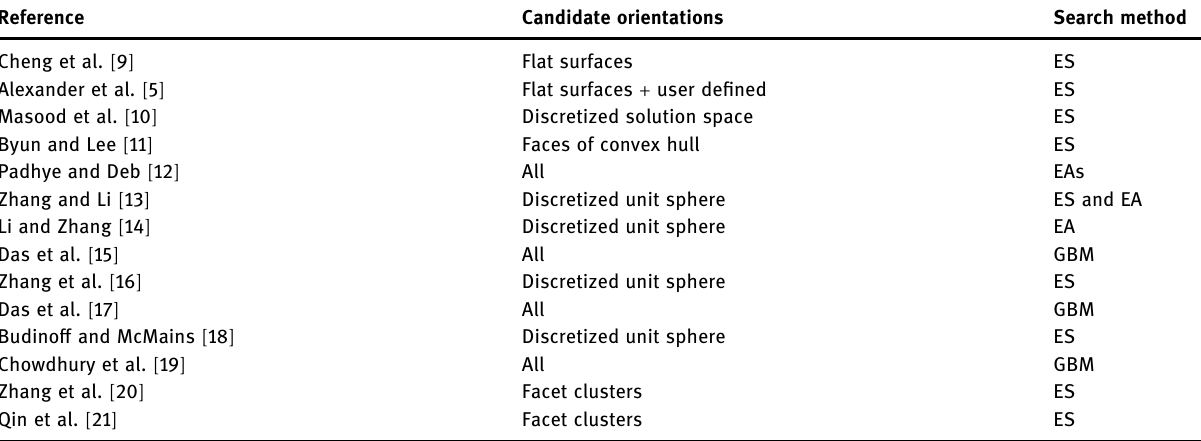
Table 1: Characteristics of related work in chronological order